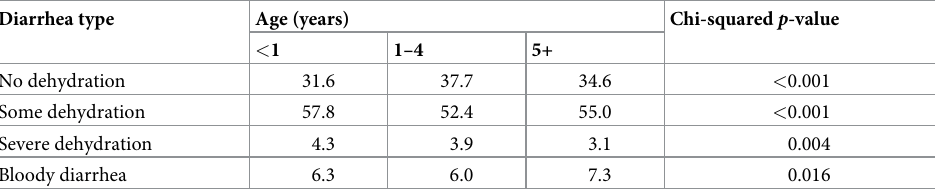
Table 3. Outpatient diarrhea cases stratified by age and type of diarrhea. Diarrhea type